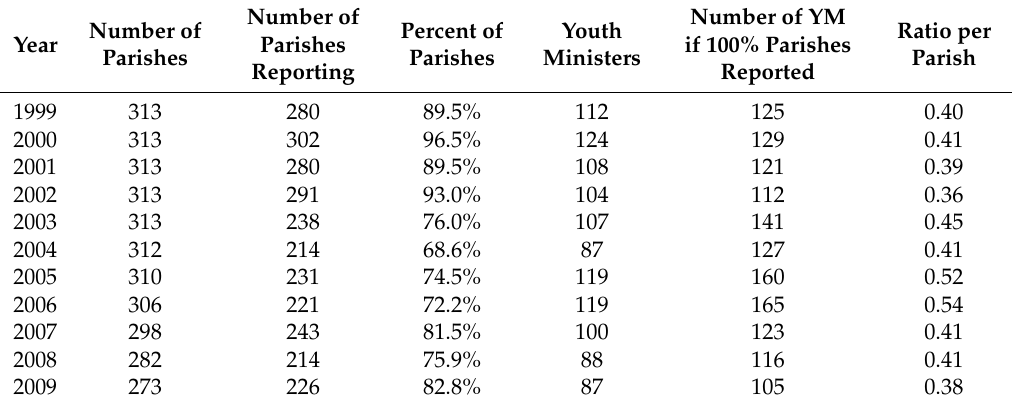
Table 1. Youth Minister Trend Data 1999–2009.